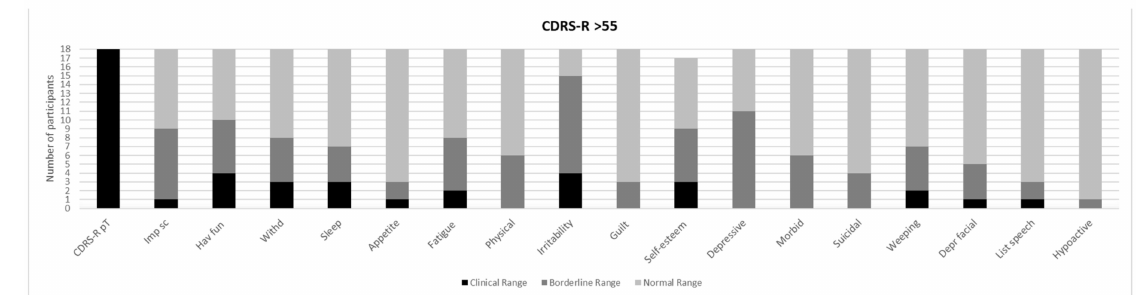
Figure 1. Prevalence of depressive symptoms in the children’s depression rating scale (CDRS-R) > 55 (CDRS-R+). Imp sc: